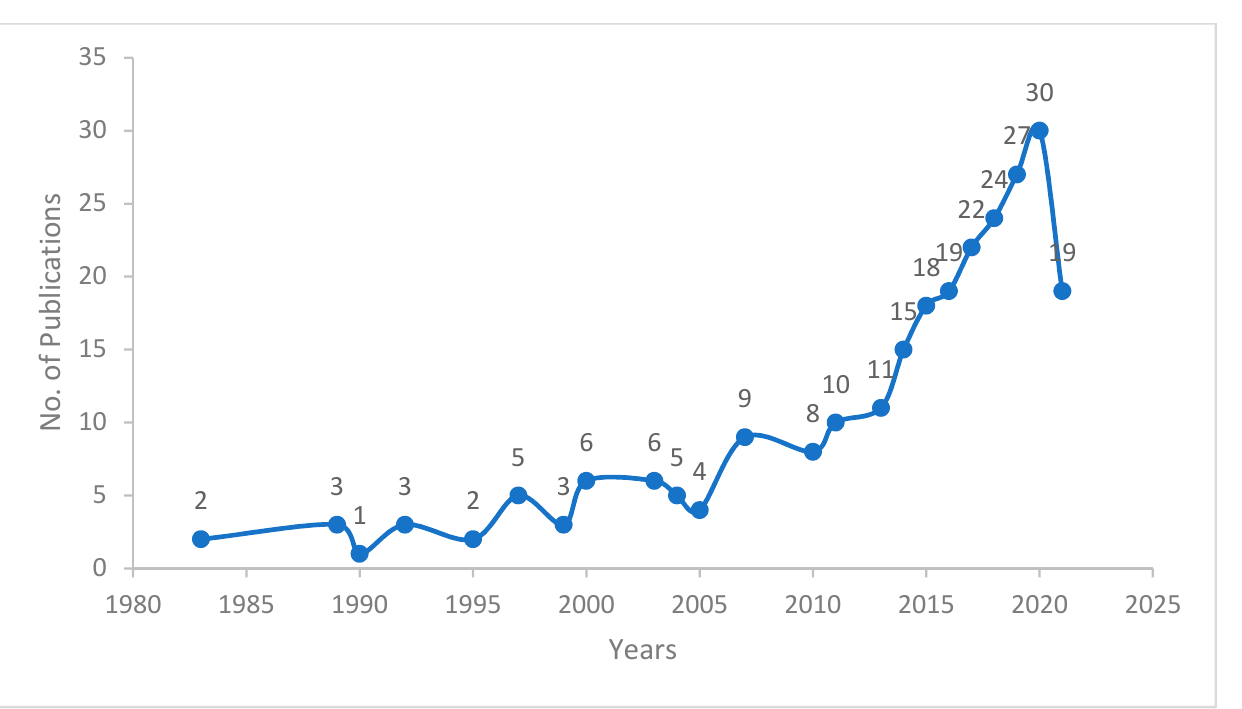
Figure 2. Annual publication trend.